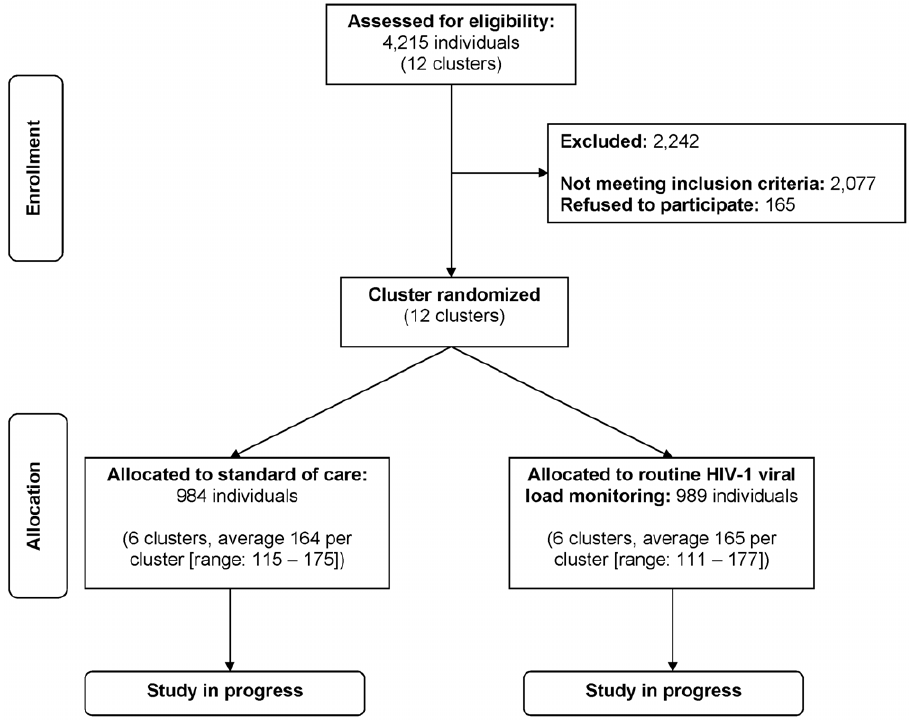
Figure 3. Participant screening and enrollment.